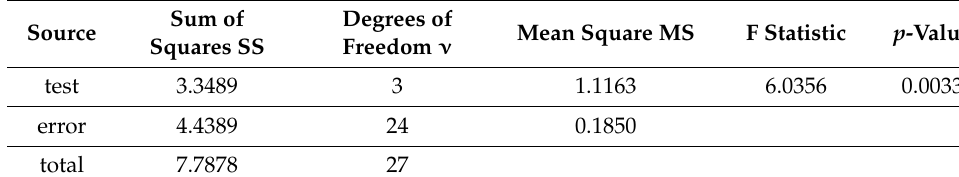
Table 8. Oculomotor SSQ score ANOVA summary.